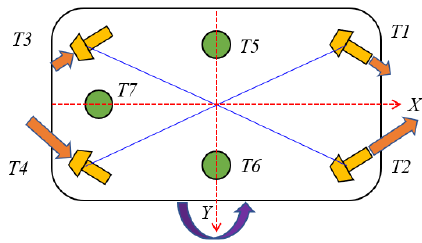
Figure 15. Thruster directions of the UUV in the turning motion.